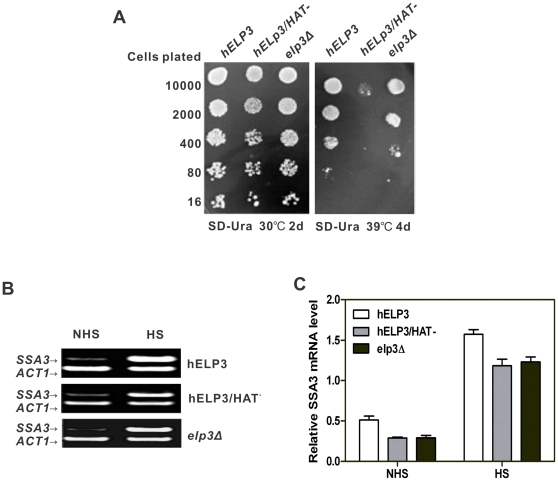
Human Elp3 can complement the growth defect and slow activation of SSA3 in elp3Δ cells and the HAT domain is essential for this function.A: Complementtation tests of hELP3, hELP3/HAT− in the elp3Δ strain. The plasmids hELP3, hELP3/HAT− were transformed into the elp3Δ strain, and the transformants were plated in a dilution series onto SD-Ura medium and grown at 30°C for 2 days, the transformants were checked for temperature sensitivity after incubation at 39°C for 4 days. B: Complementation of the slow activation of SSA3 in elp3Δ cells. Cells were grown at 26°C before transfer to 37°C to activate the SSA3 gene. Total RNA was extracted for RT-PCR at 0 or 10 min after heat shocked. The RT-PCR products derived from transcripts of SSA3 and ACT1 (the internal control) are shown in the left panel. The panels on the right show the results of the quantitative densitometric analyses of the band intensities at each time-point.